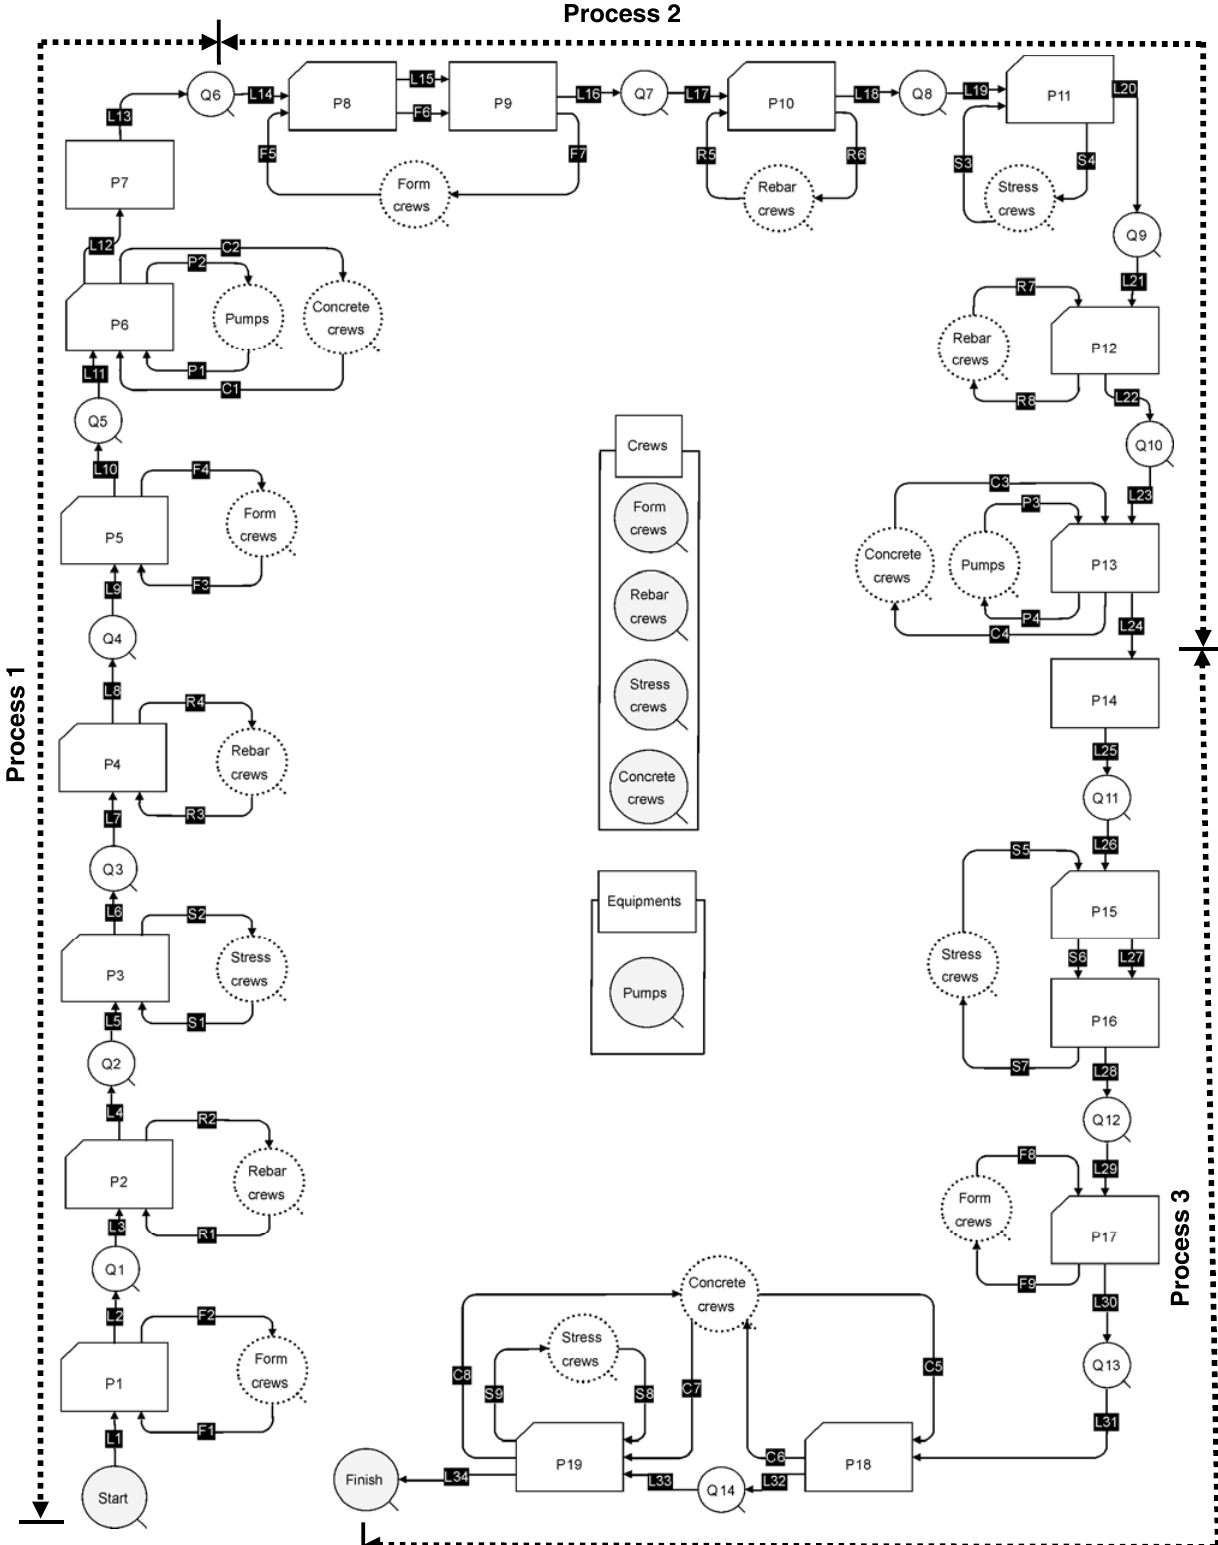
Fig 3 . Simulation network for single form